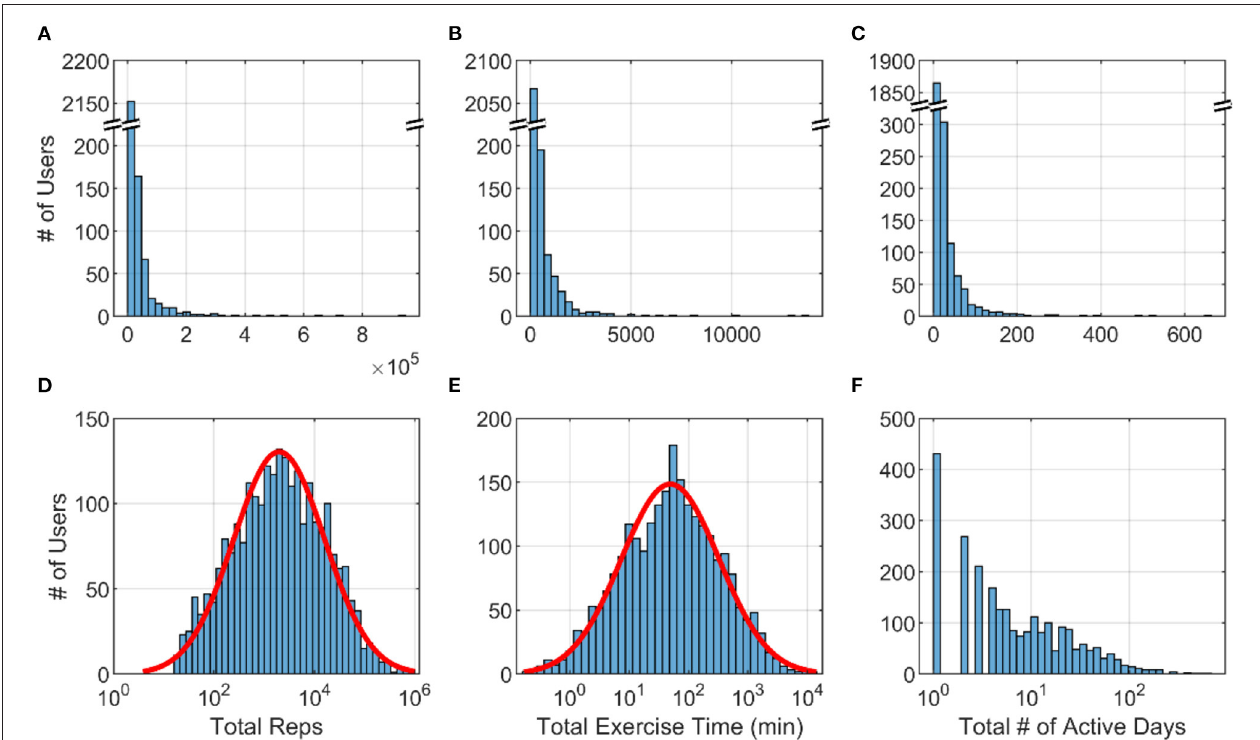
FIGURE 4 | Histograms across 2,464 FitMi users for (A) total repetitions (B) total exercise time and (C) total active days. (D–F) show the same data plotted on a log scale for the x-axis. Red lines are best-fit normal distributions.